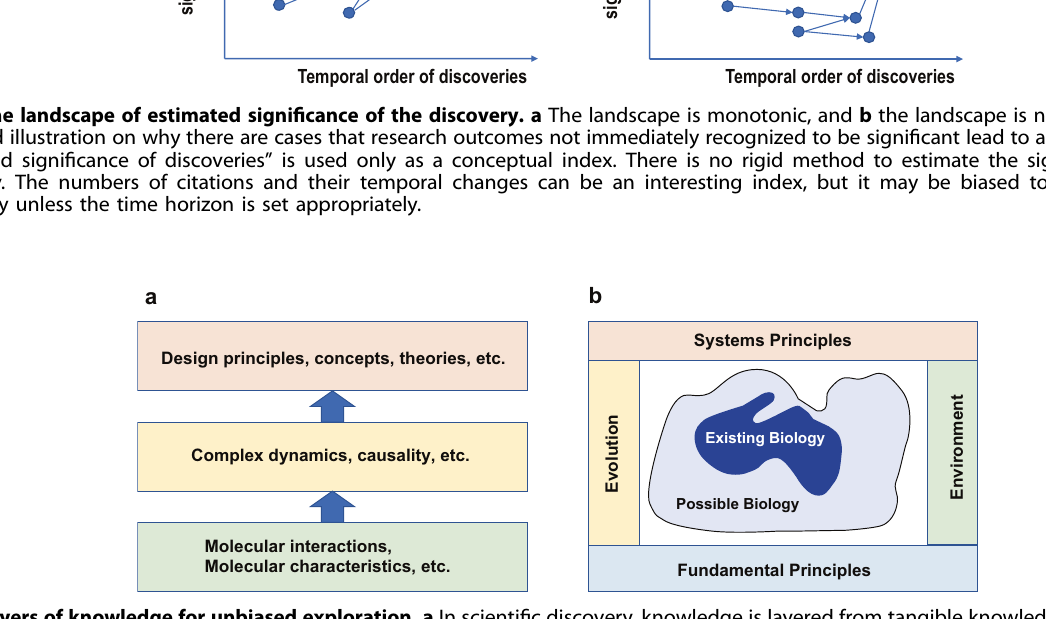
Fig. 7 Layers of knowledge for unbiased exploration. a In scienti fi c discovery, knowledge is layered from tangible knowledge to conceptual knowledge. Properties of molecules and their interactions are tangible and knowledge of systems dynamics and design principles are conceptual as they are not directly associated with tangible objects such as molecules and cells. Conceptual knowledge is often backed by mathematical and system-oriented theories. b Biology that we observe ( “ existing biology ” ) is constrained by multiple factors such as fundamental principles, systems principles, environmental constraints, and evolutionary selection. “ Possible biology ” meets all constraints but has not been observed or realized